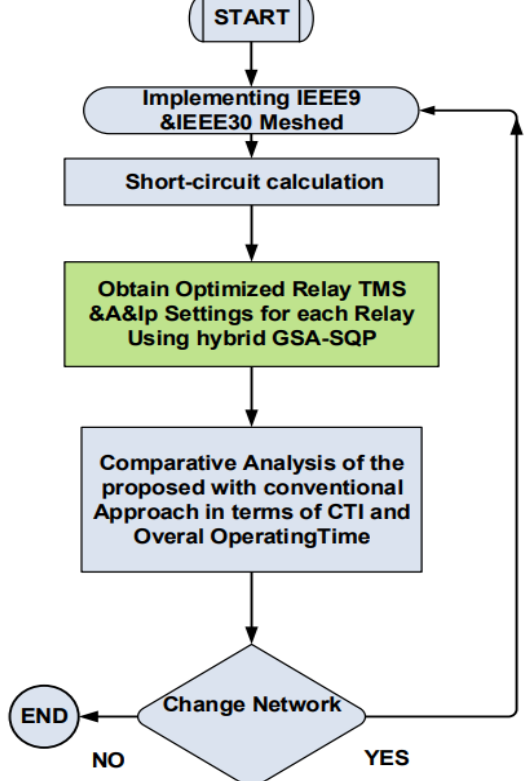
Figure 12. Meshed Networks Flowchart of the Proposed NSTCC.